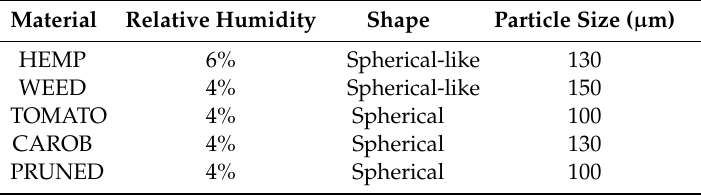
Table 1. Main characteristics of the particles used as a filler phase from agricultural